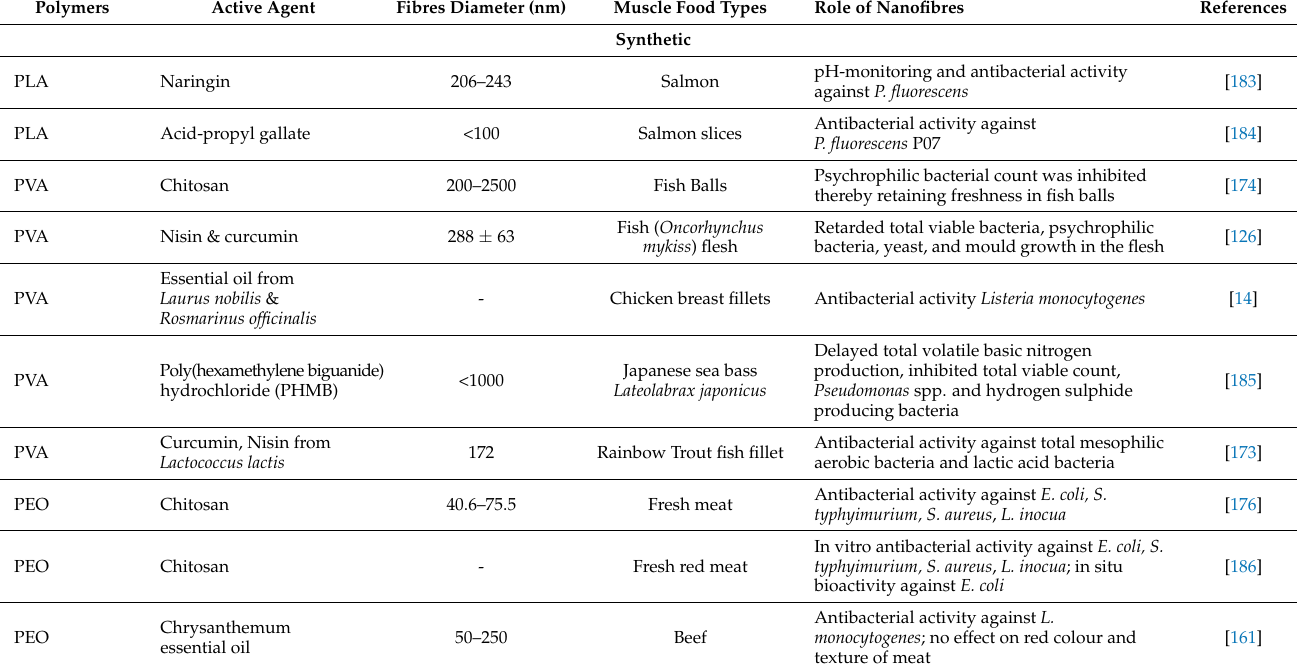
Table 2. Brief summary of the applications of active electrospun fibres in meat processing and